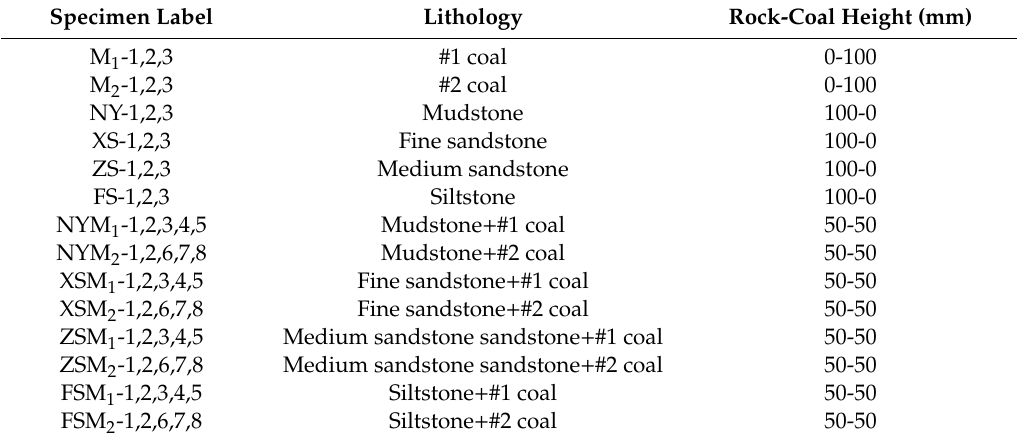
Table 1. The lithology and size of the specimens.